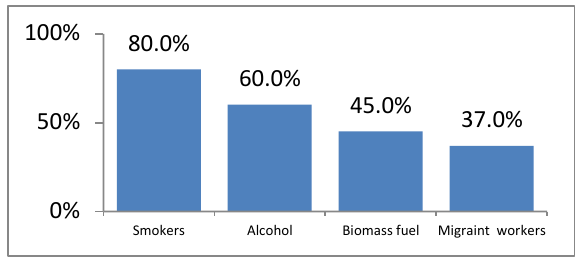
Figure 2. Common risk factors